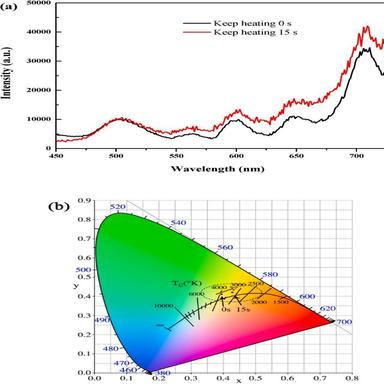
(a) Afterglow spectra for BGO: 0.005Bi3+ sample after heating at 150 ◦C for 0 s, and 15 s, and (b) corresponding CIE coordinates of the afterglow spectra for BGO: 0.005Bi3+ sample. The sample was excited by 254 nm UV lamp for 5 min. When the afterglow disappeared completely after removing the irradiation source, the sample was heated at 150 ◦C for 15 s.